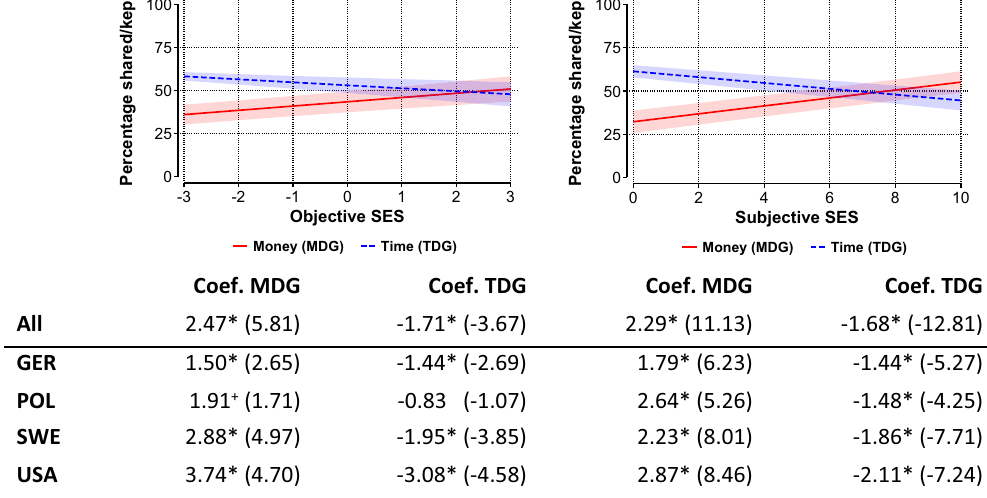
Figure 1. Higher-status individuals give more in the MDG and spend less time on the task in the TDG. Shown are results of Cragg models for the second stage on percentages shared in the MDG and percentages of work time kept in the TDG (y-axis), depending on objective SES (x-axis, left) and subjective SES (x-axis, right); shown are predicted percentages with 95% confidence intervals. The plots refer to all countries (pooled model), and coefficients and z-values of status effects are presented for all countries and separately for each country (Germany, Poland, Sweden, USA). For both MDG and TDG, higher values on the y-axis indicate more prosocial behavior. For both objective SES and subjective SES, higher values on the x-axis indicate higher SES. + and * denote significant differences at least at the 10% level and 5% level, respectively (for full models see Tables S1 and S2, suppl.